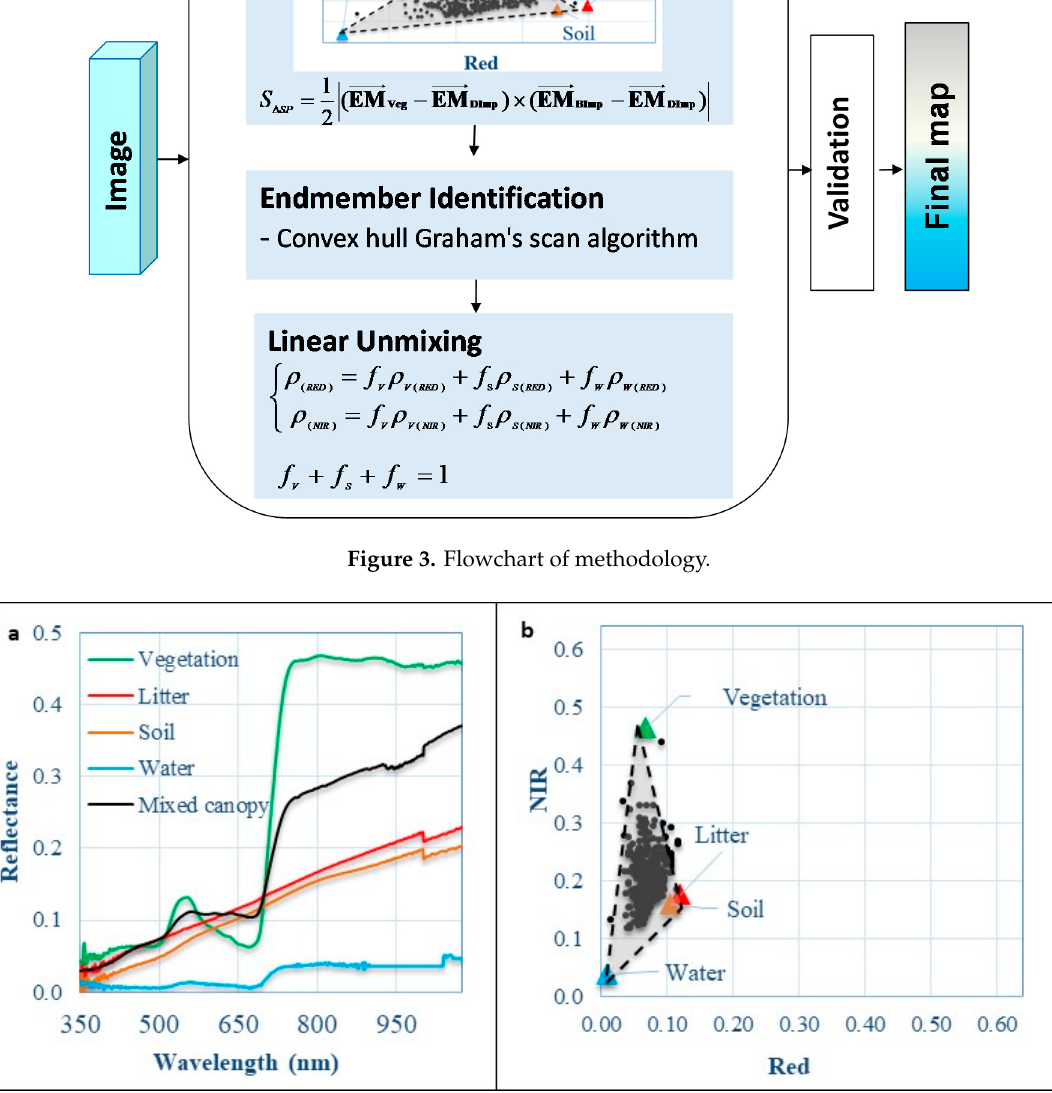
Figure 4. Geometric interpretation of the mixture problem in a two-dimensional space using field-collected hyperspectral data; ( a ) field observed spectra curves of typical ground features including vegetation, litter, soil, water, and a mixed canopy; ( b ) point cloud plotted from field spectral simulated Landsat Thematic Mapper (TM) red and near-infrared (NIR) bands for the typical ground features (vertexes forming a triangle shade) and for all field-collected plot spectra (black dots).